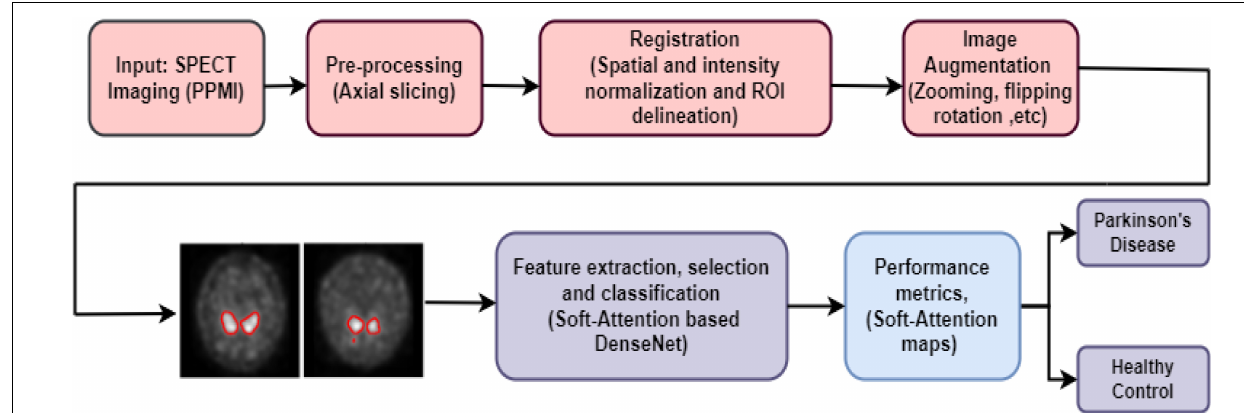
FIGURE 4 | Overall block diagram of the proposed work.